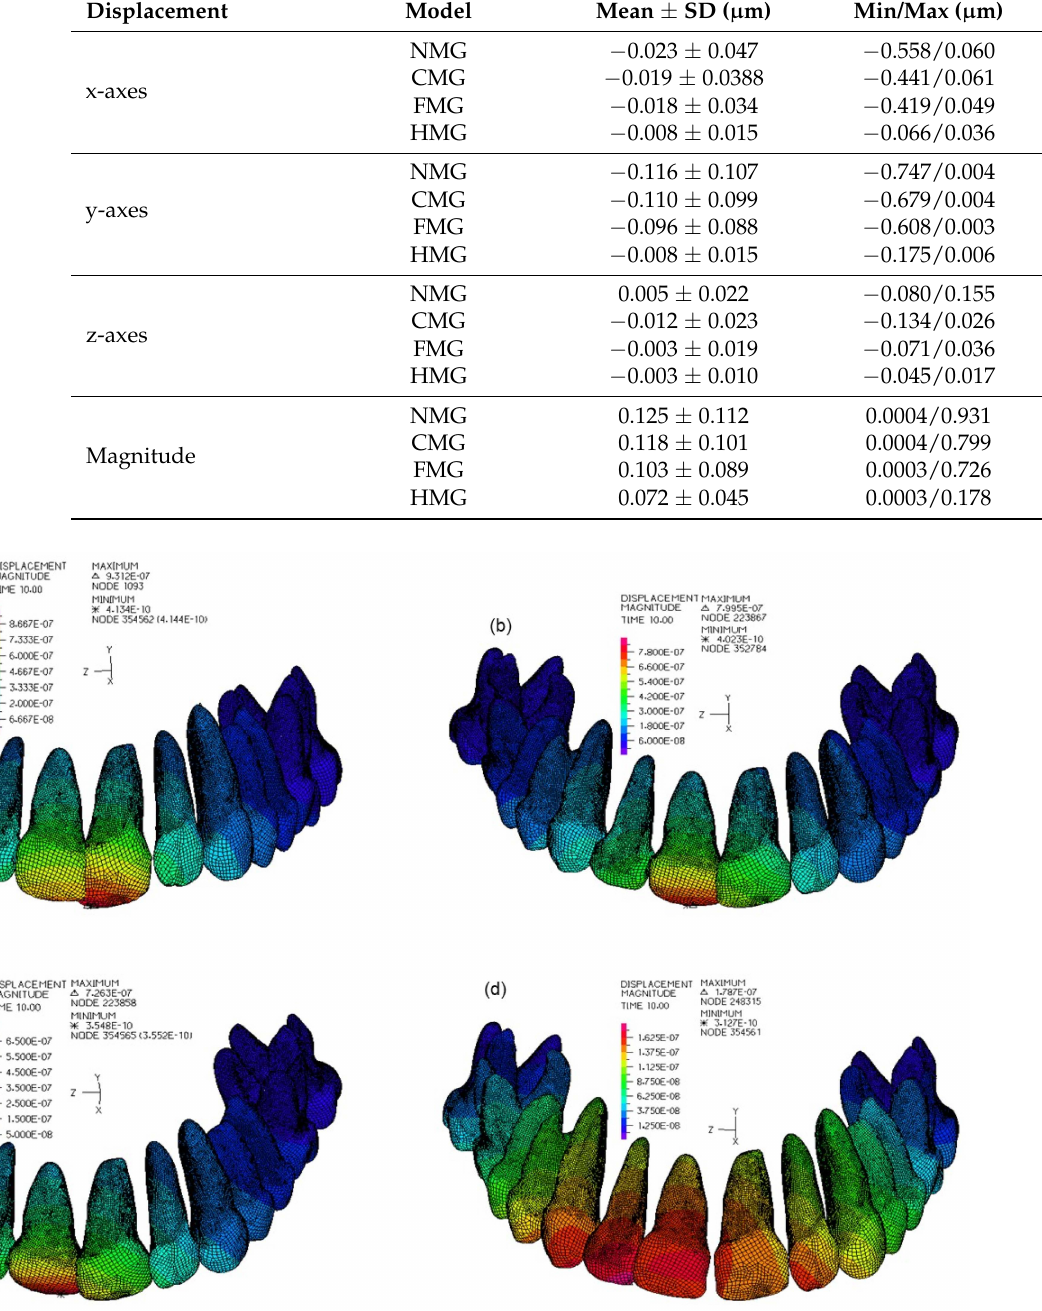
Figure 5. Pattern distribution of the magnitude of displacement field: ( a ) in the NMG model; ( b ) in the CMG model; ( c ) in the FMG model; ( d ) in the HMG